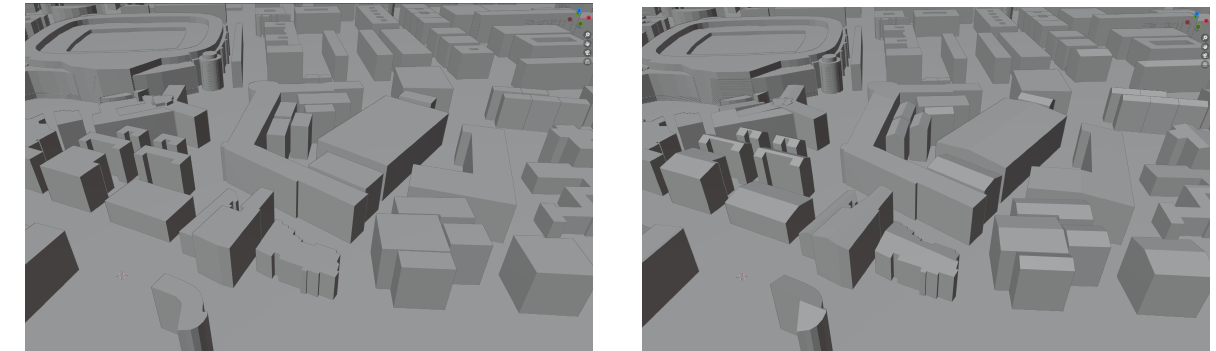
Figure 9. Madrid area without inferred roofs ( left ) and with inferred roofs ( right ).